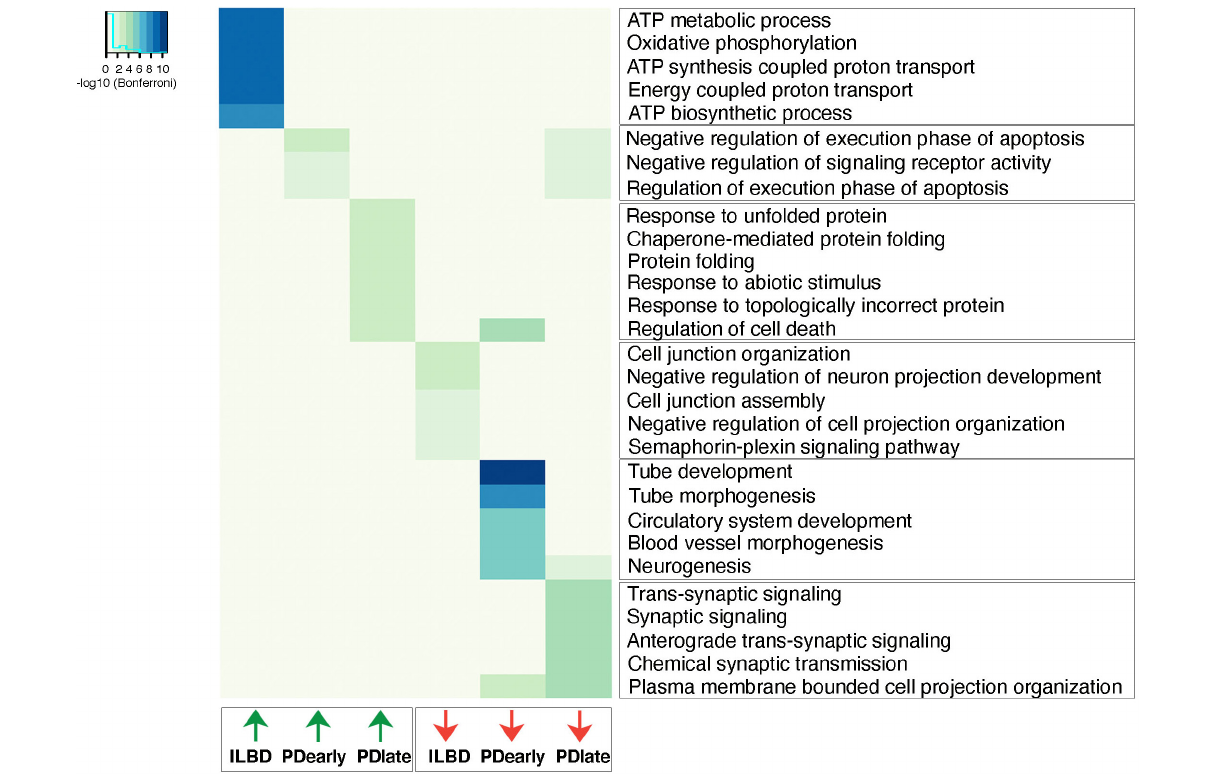
FIGURE 6 | Up- and down-regulated biological processes in PDearly, PDlate and incidental Lewy body disease. Top significant biological process categories from differentially expressed genes (padj < 0.05, RPKM in controls > 1, fold change > 1.5) as analyzed by ToppGene suite. Heatmap indicates significance of each individual GO-term as revealed by Bonferroni